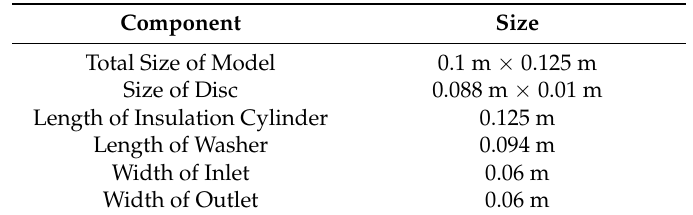
Table 1. Model Sizes.